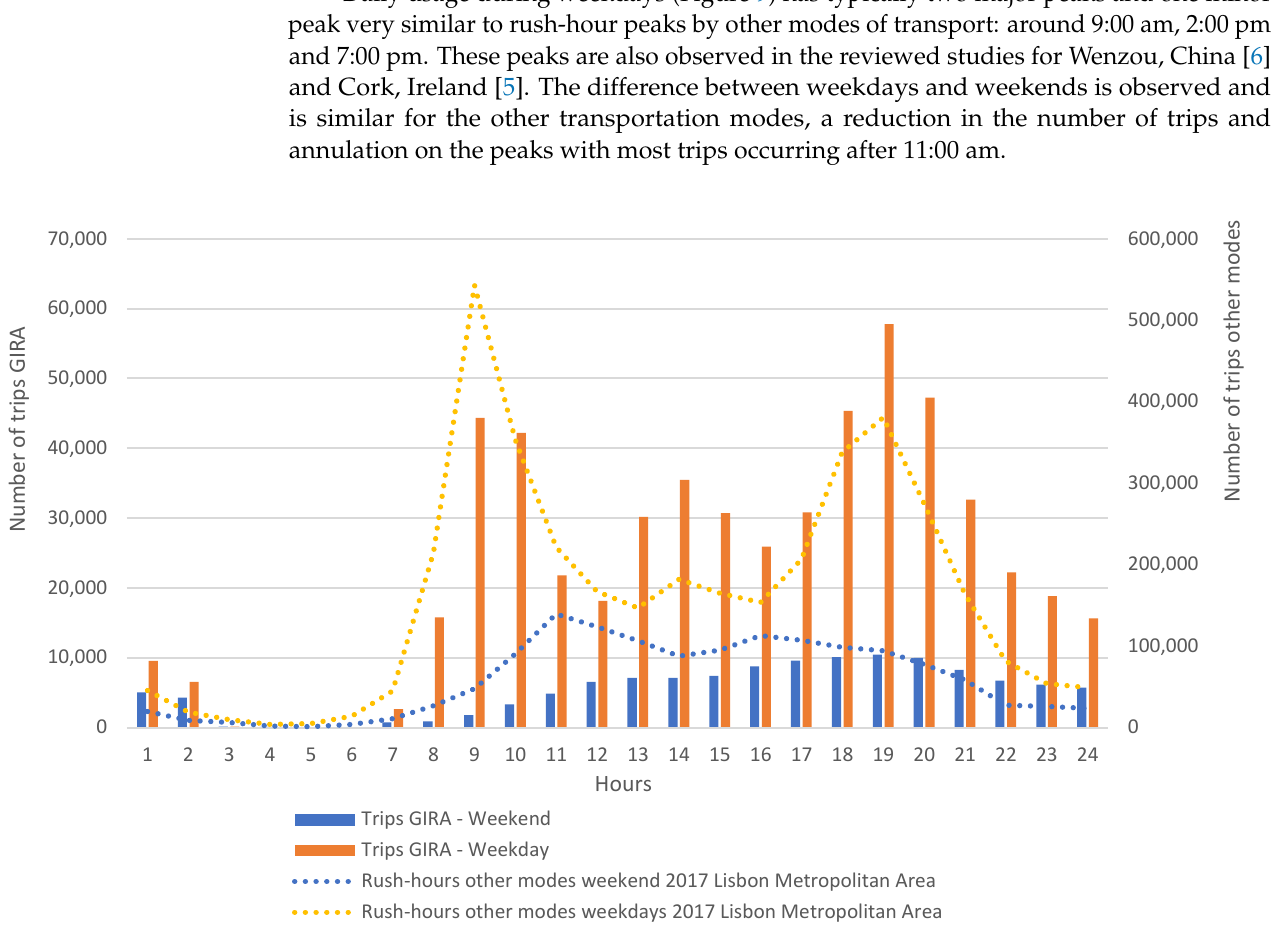
Figure 9. Rush hours of usual passenger transportation trips (see Figure 4) versus GIRA